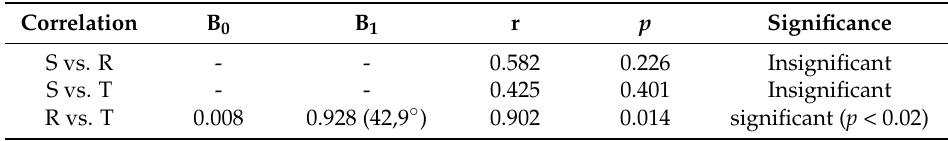
Table 3. Linear regression of the IC 50 values for triorganotin cell death effects on S, R and T cells. Correlation B 0 B 1 r p Significance